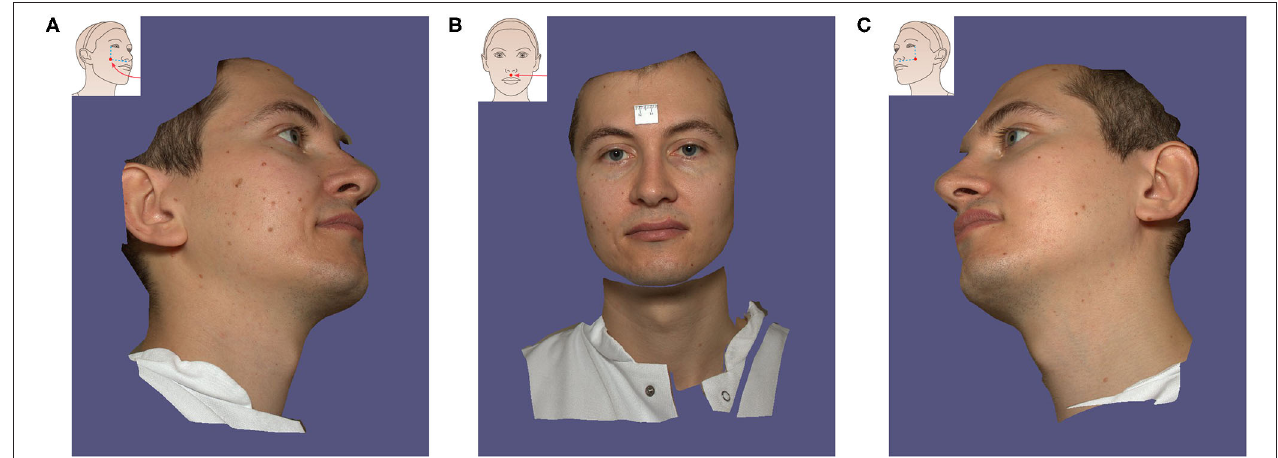
FIGURE 1 | The process of 3D image acquisition with Vectra H2 portable camera. The volunteer follows the instructions to turn the head to the left (A) , turn the head to look forward (B) , and finally turn the head to the right (C) . The application instruction screen for each step is displayed in the upper right